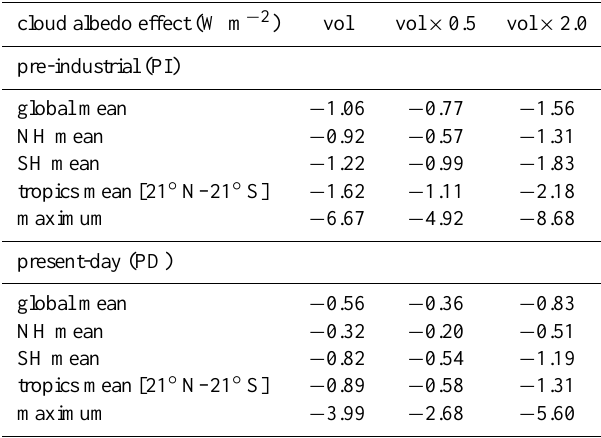
Table 4. Annual mean cloud albedo effect at the top of the atmo- sphere for changes of low- and mid-level clouds (up to 600hPa) induced by volcanic degassing (i.e. w.r.t. the runs without volcanic emissions) for pre-industrial (PI) and present-day